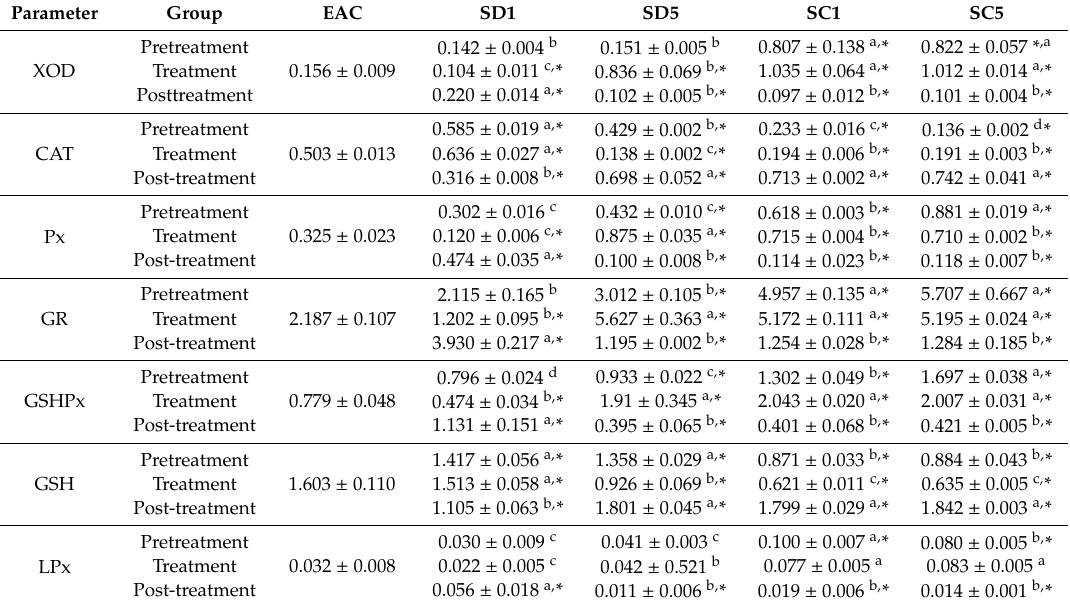
Table 1. Impact of S. montana extracts on biochemical parameters in EAC